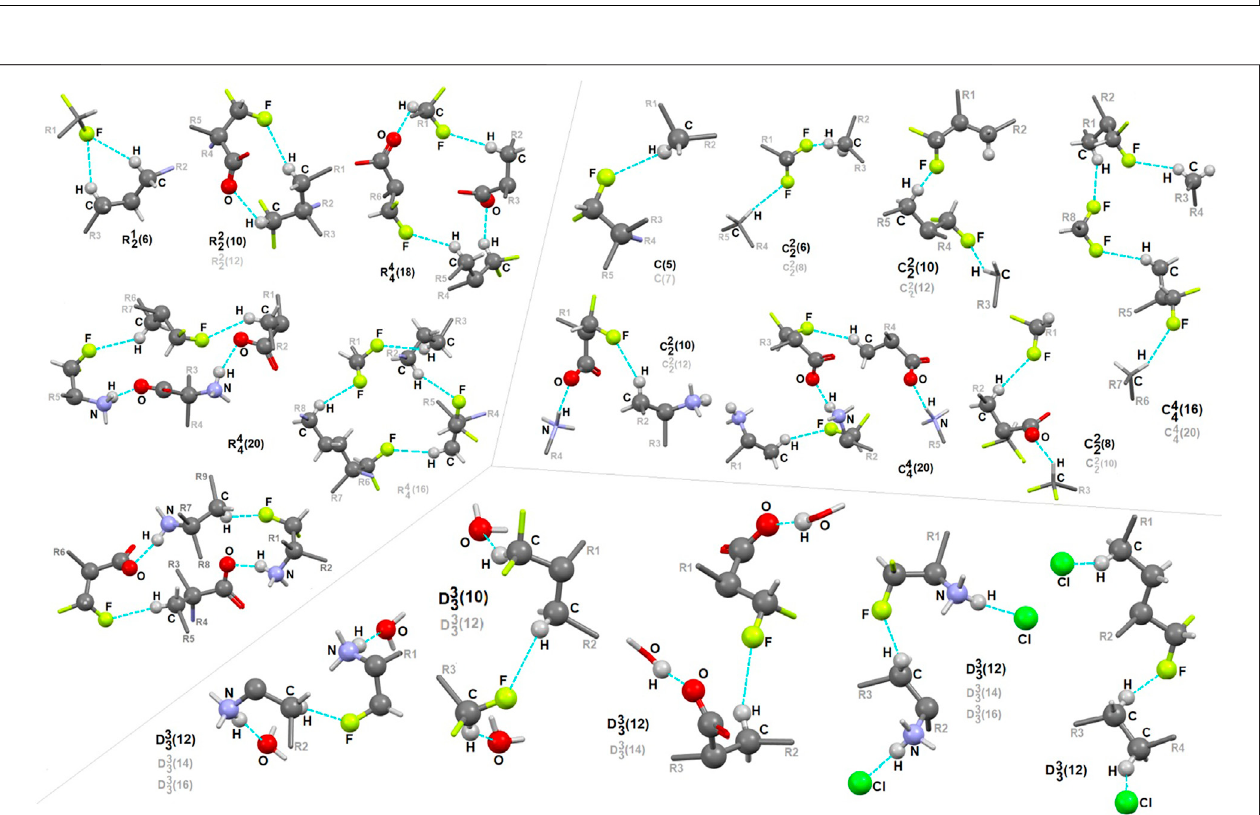
FIGURE 11 | Gallery of fluorine-based supramolecular motifs grouped into ring-, chain-, and fi nite chain-D- H-bonding motifs, encountered in analyzed supramolecular systems. The atom-numbering scheme for interacting atoms is included. For clarity, side chains were eliminated.